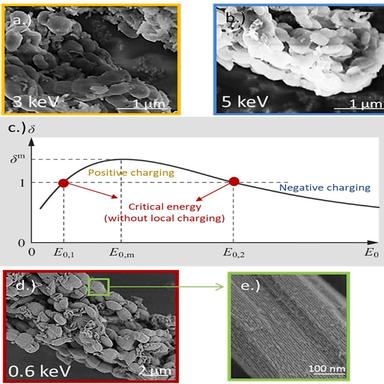
SLEEM images taken with different slow energy electron beams. Depending on the beam energy, positive charging, negative charging, or no charging may occur. In the first two cases, the images are blurred. However, in the last case, where 0.6 keV electron beam is used, the image is clearer (c.)). This is achieved by choosing the electron beam as 0.6 keV at which positive charging and negative charging balance out. Note that such clear surface images are difficult to obtain for materials such as mesoporous sil